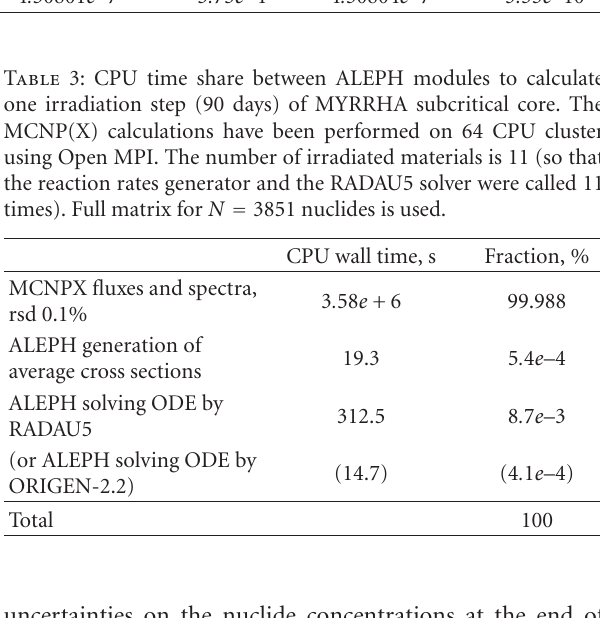
Figure 1: Elapsed CPU time as a function of the number of ODE equations.